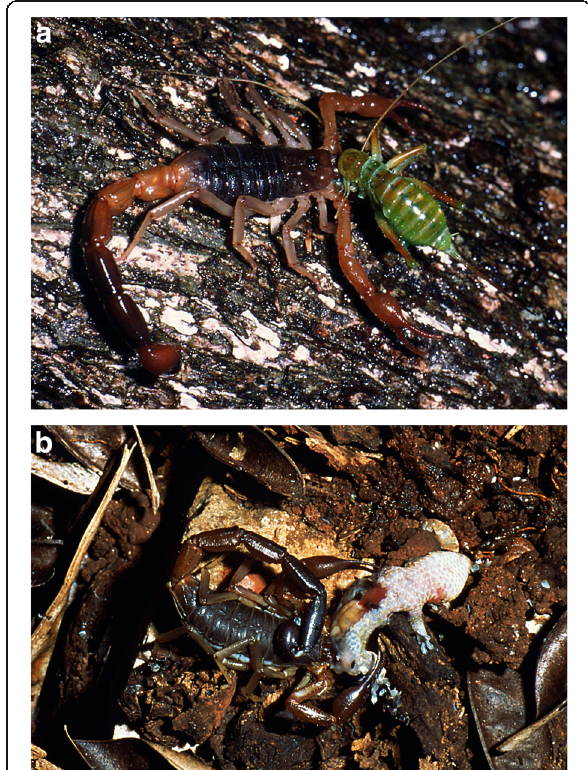
Fig. 3 Grosphus flavopiceus Kraepelin from Madagascar. An adult female feeding respectively on ( a ) an insect (Orthoptera) and on ( b )